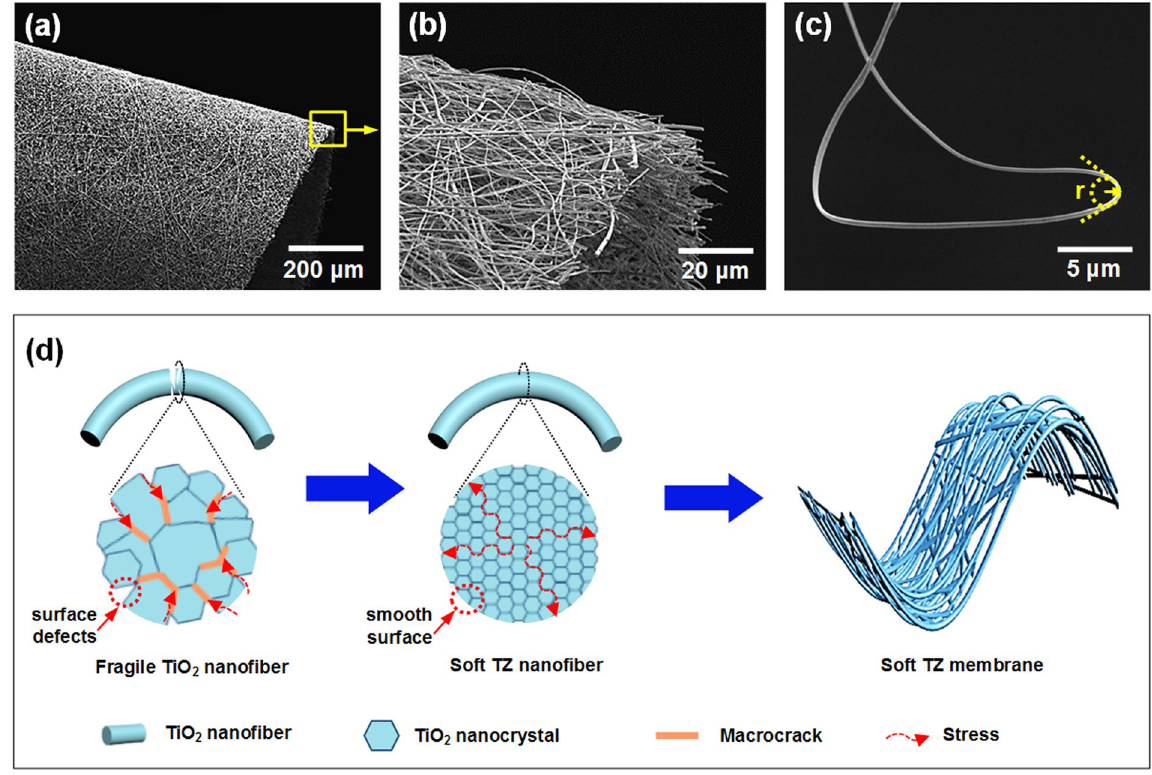
Figure 6. ( a ) SEM image of the bended TZ-10 nanofibrous membranes. ( b ) The high magnification SEM image of selected area in ( a ). ( c ) SEM image of bended single TZ-10 nanofiber. ( d ) Schematic illustration showing the probable mechanism of the softness of TZ